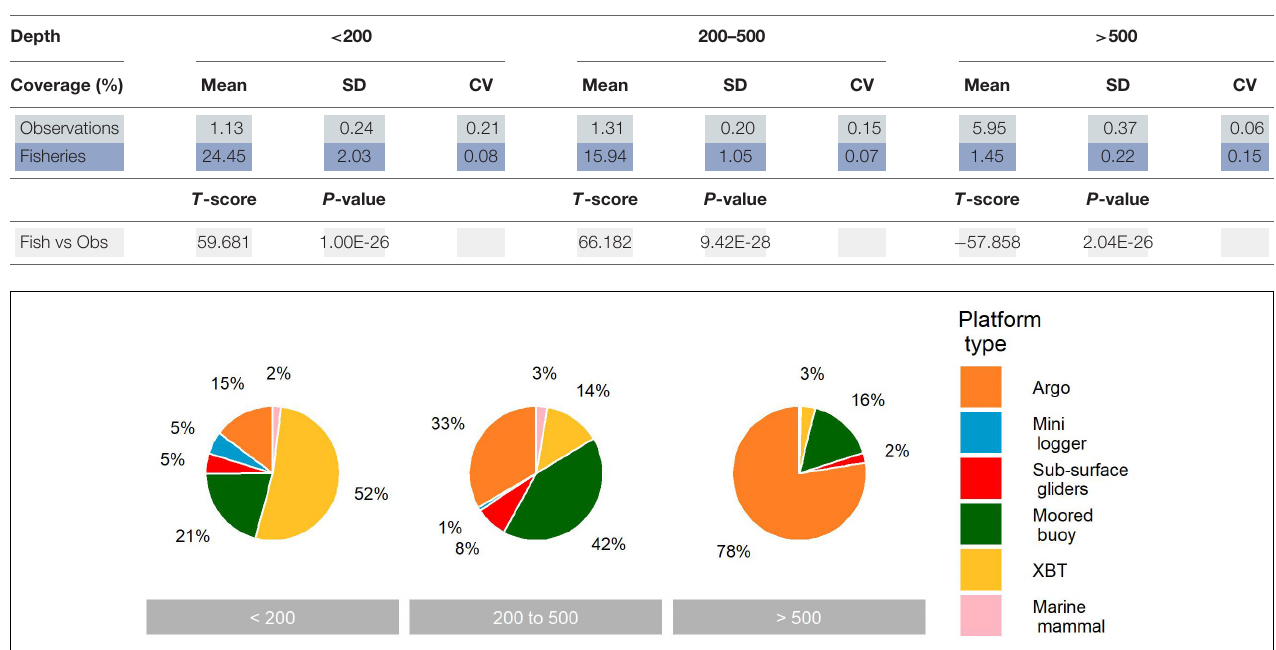
FIGURE 11 | Percent contribution by each platform to total observational instances. Note: the number of observations a moored buoy delivers is capped by our methodology at once per day.